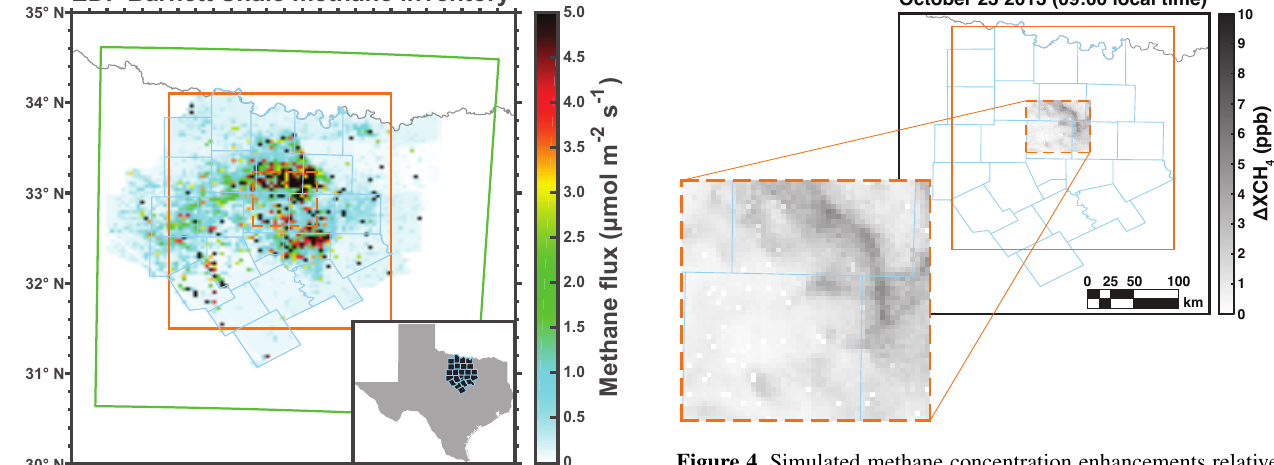
Figure 4. Simulated methane concentration enhancements relative to background ( (cid:49)X CH 4 = Hx ) in the 70 × 70km 2 observation do- main of the Barnett Shale (dashed orange box), as derived from the downscaled EDF methane inventory ( x ) and the WRF-STILT foot- prints ( H ) within the 290 × 235km 2 OSSE domain (solid orange box). Values are for 23 October at 09:00LT. Zeros are due to miss- ing data because of unfinished